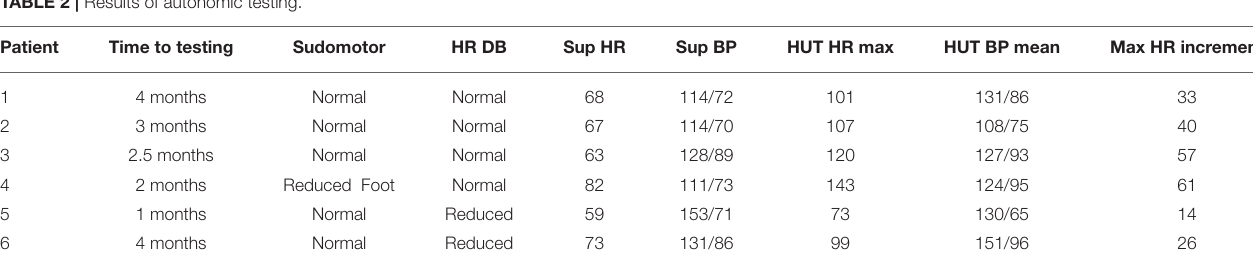
TABLE 2 | Results of autonomic testing. Patient